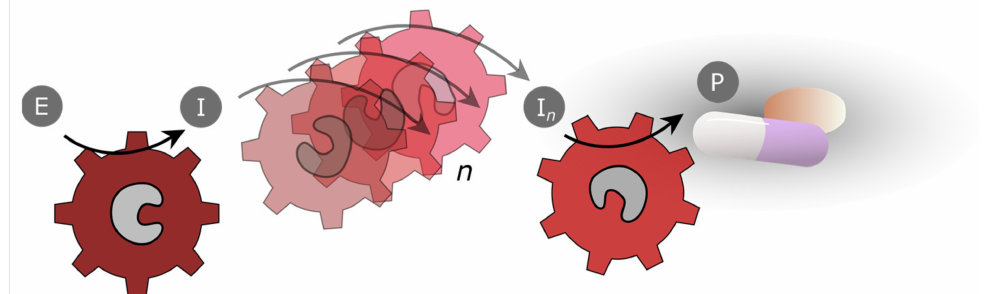
Figure 13. Schematic representation of an enzyme cascade for drug synthesis. Two plus n enzymes can participate in product production ( n ≥ 0). E, educt; I, intermediate; P,